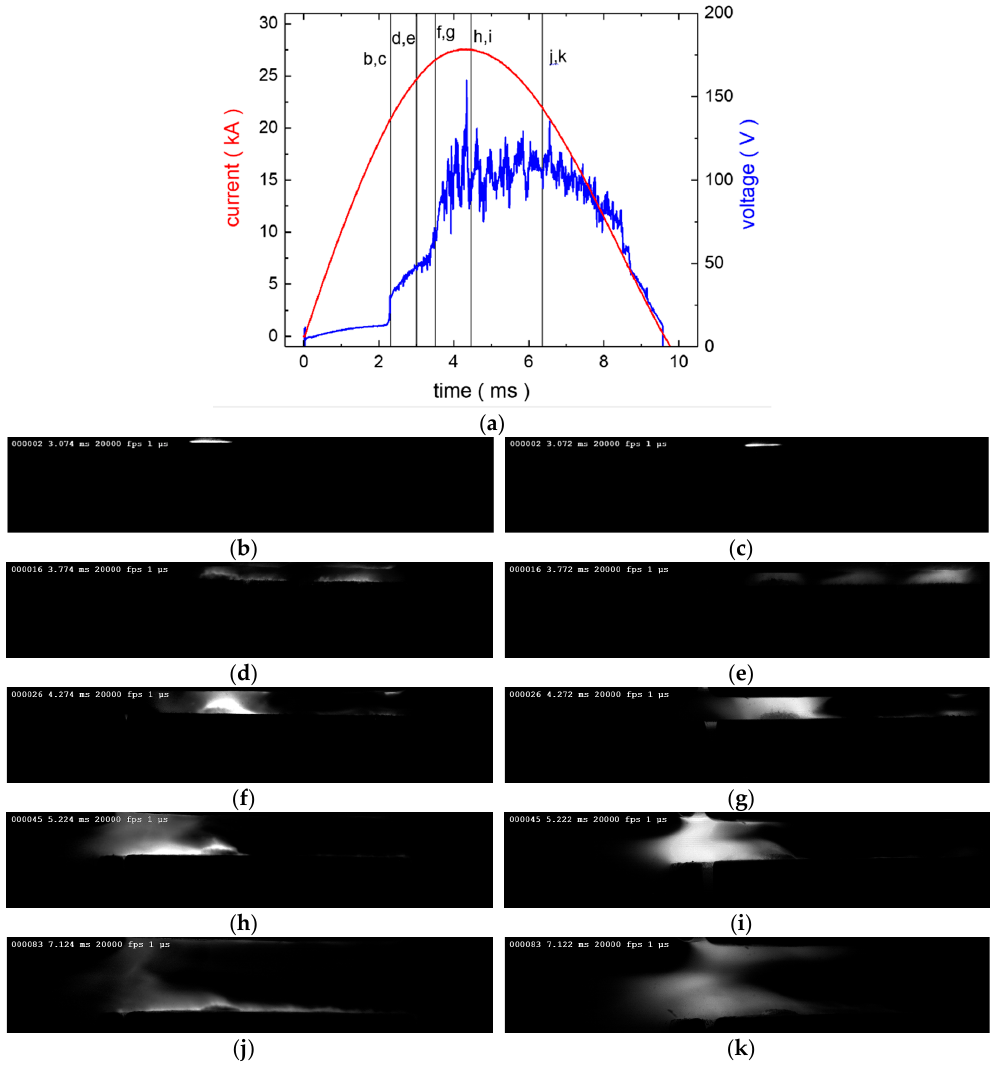
Figure 7. ( a ) Temporal evolution of arc current and voltage. Vertical lines show the instants for which the arc images are presented. ( b – k ) Spectrally filtered arc images at di ff erent time instants. Images ( b , d , f , h , j ) show Cu I emission, ( c , e , g , i , k ) that of Cu II. Electrode type